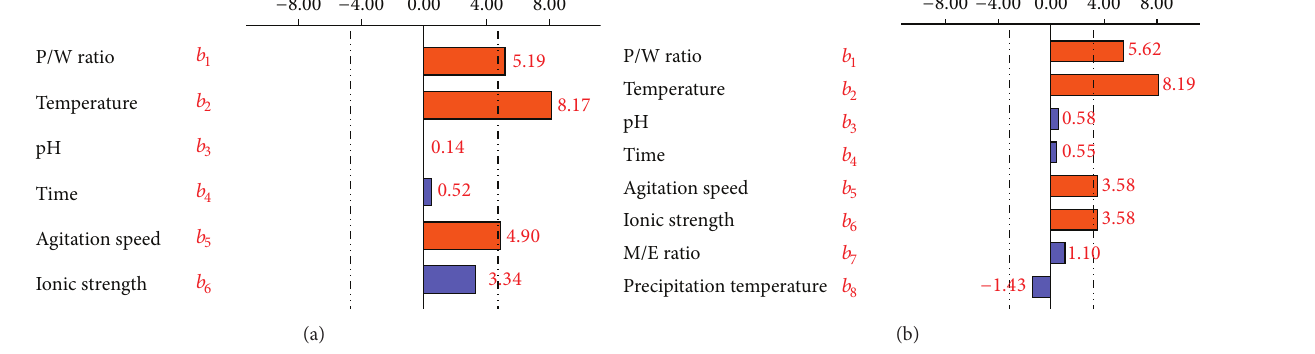
Figure 2: Graphical study of factor effects on soluble and insoluble fibres extraction (screening step): (a) insoluble fibres screening design and (b) soluble fibres screening design.